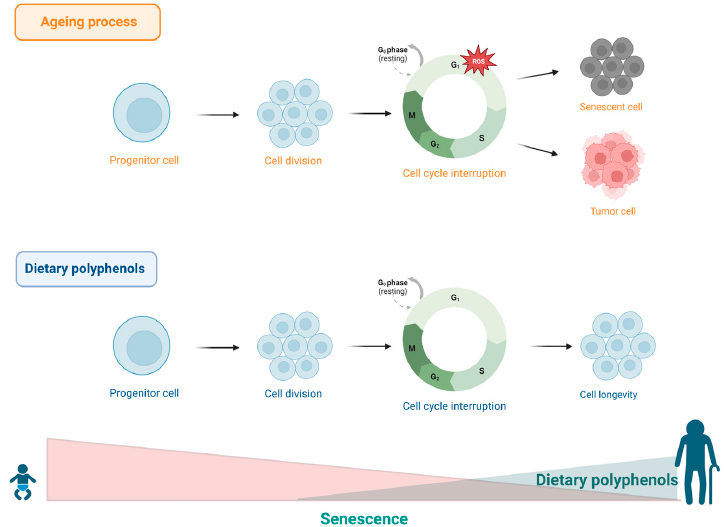
Figure 7. During ageing, stress or excessive cellular damage favours cellular ageing. This process is characterized by irreversible arrest of the cell cycle in the G1 phase. Dietary polyphenols offer ben- efits to cellular homeostasis, contributing to cell